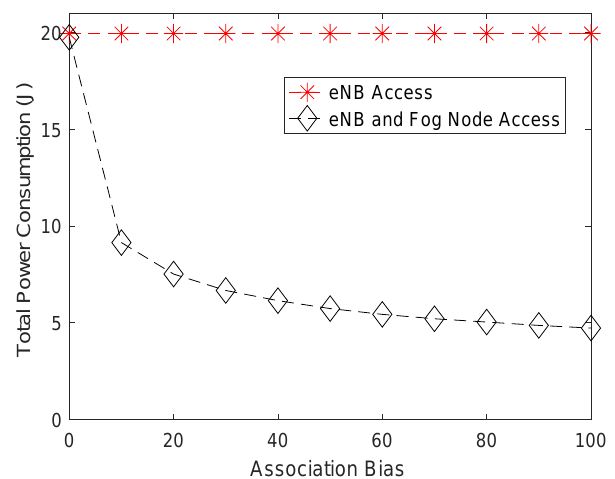
Figure 4. The total power consumption under different access